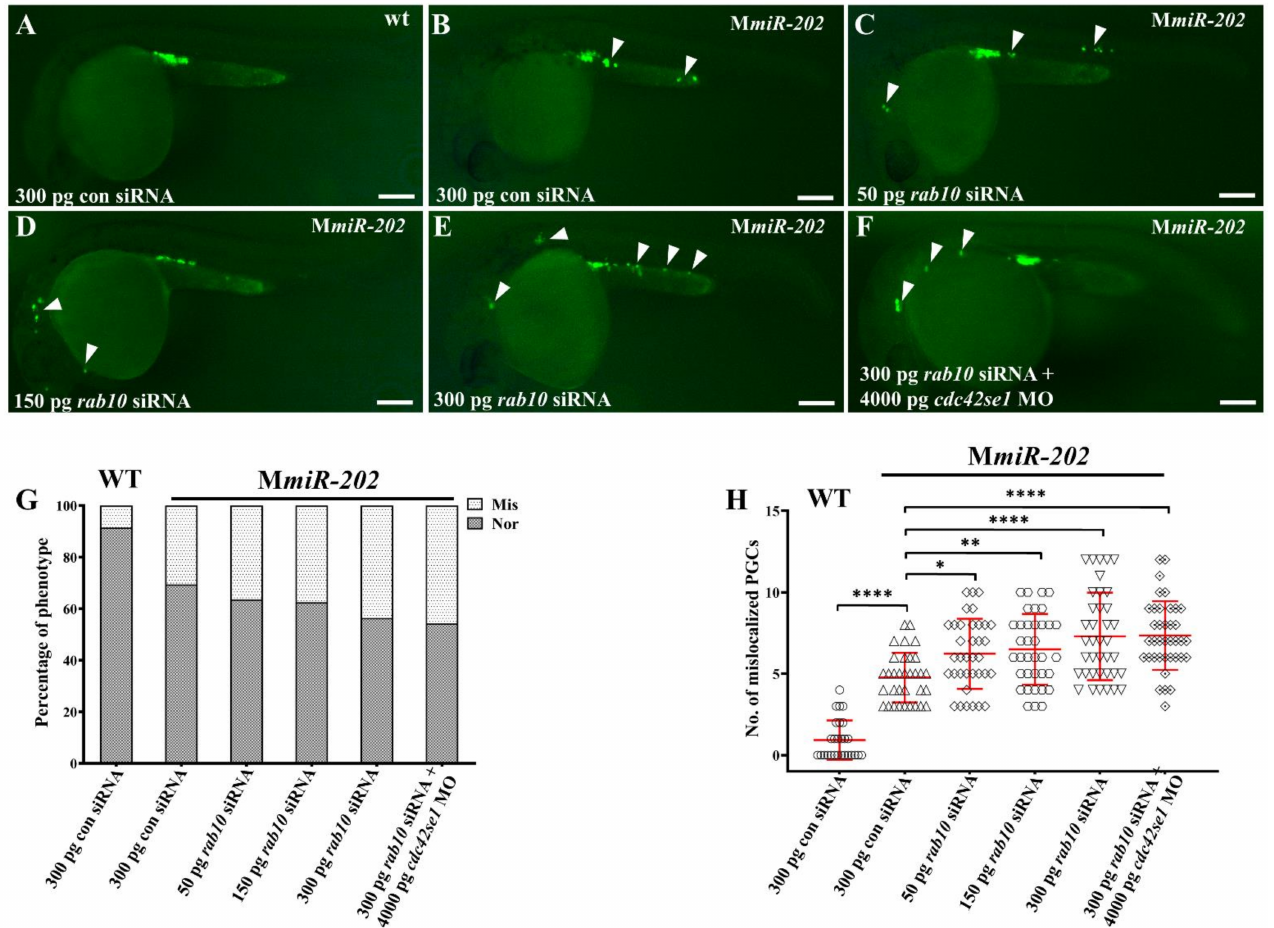
Figure 7. rab10 siRNA and cdc42se1 MO failed to rescue mislocalized PGCs in embryos caused by maternal absence of miR-202-5p . ( A ) Representative images of PGCs in WT embryos injected with 300 pg con siRNA; ( A ) Representative images of PGCs in Mmir-202 embryos injected with 300 pg con siRNA ( B ), 50 pg rab10 siRNA ( C ), 150 pg rab10 siRNA ( D ), 300 pg rab10 siRNA ( E ), and 300 pg rab10 siRNA + 4000 pg cdc42se1 MO ( E ). Arrowheads indicate mislocalized PGCs. ( G ) The percentage of embryos with mislocalized PGCs with ( A – F ). The genotypes of the embryos were shown upper right in each panel. ( H ) The number of mislocalized PGCs in each embryo in the experiment presented in ( A – F ). ( G , H ) The results were representative of more than three independent experiments in triplicate. The average number of mislocalized PGCs were showed in red line by mean ± sd. * p < 0.05, ** p < 0.01, **** p < 0.0001. Scale bar, 100 µ